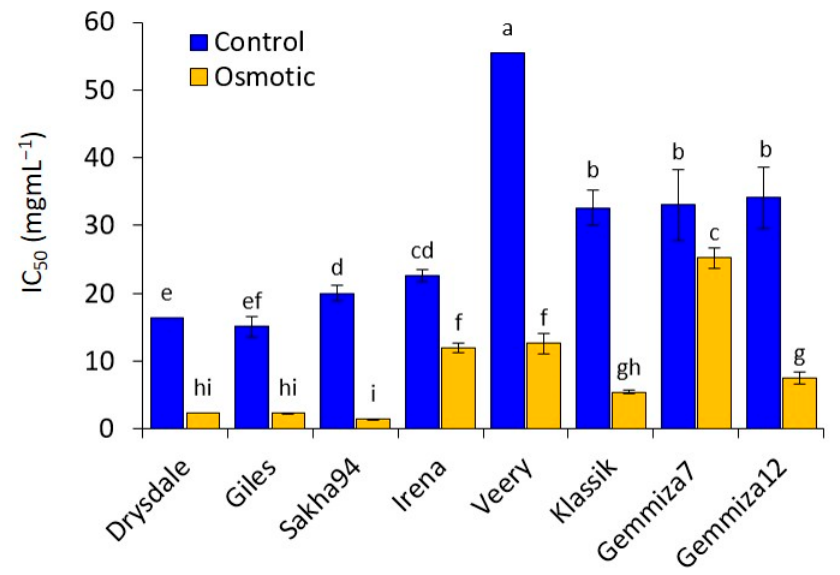
Figure 3. Calculated IC 50 for root extracts 14 DAT, demonstrating a genotype × treatment interac- tion ( p = 0.0001). Data points within genotypes and treatment having the same letter are not signif- icantly different at the 95% level of confidence.